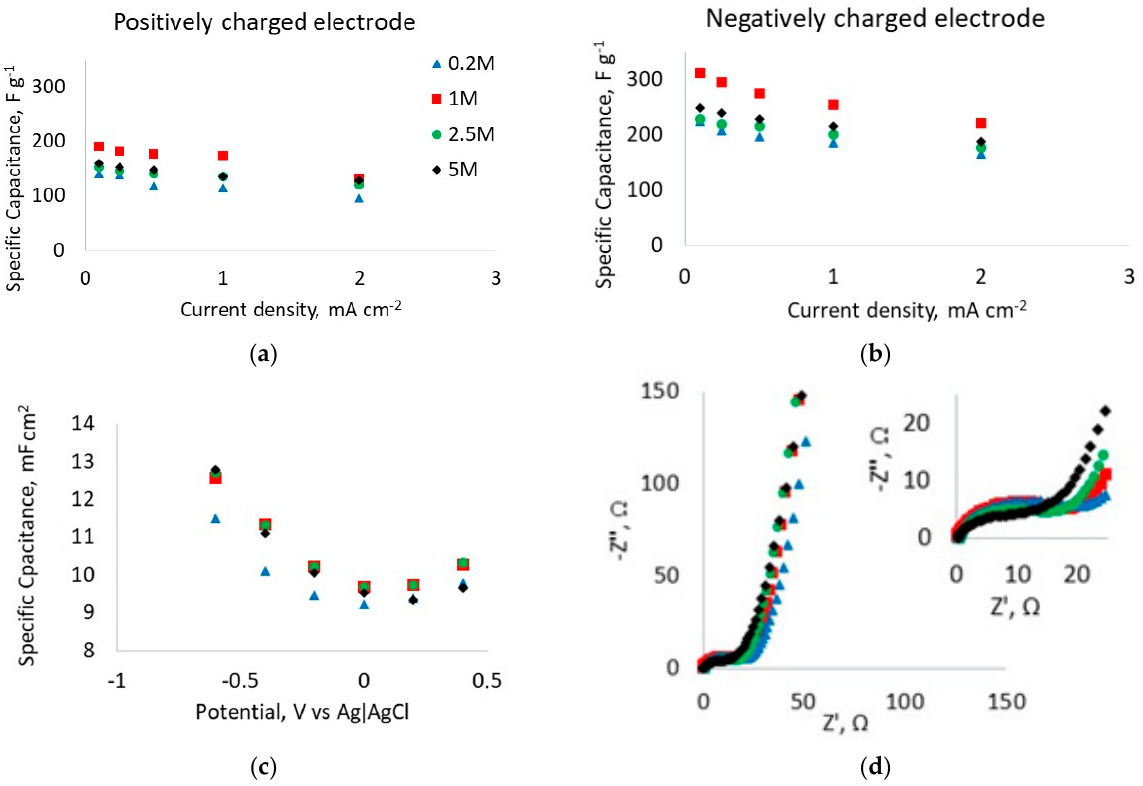
Figure 7. Electrochemical performance of “electropsun” CDC-based fibrous electrodes in xM NaNO3 electrolytes: ( a , b ) capacitance values obtained from CC discharge plots at I = 0.5 mA cm-2 for positively and negatively charged electrodes, ( c ) Cs (at I = 50 mHz) as a function of potential from EIS measurements and ( d ) Nyquist plot at 0 V (vs. Ag|AgCl).